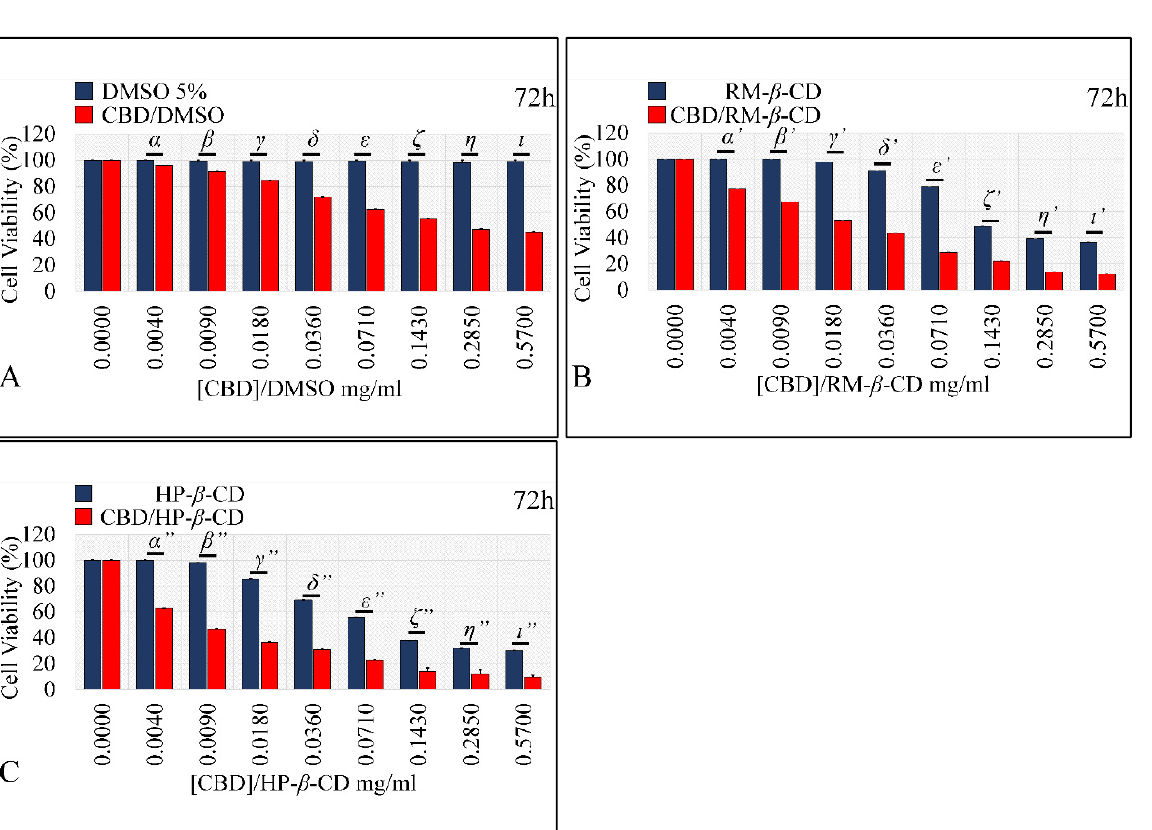
Figure 11. Comparison of vehicle-only and vehicle/CBD complexes on A172 cells at 72 h. ( A ) DMSO did not have any effect on cells, whereas CBD/DMSO manifested significant cytotoxicity as compared to the vehicle at all concentrations, except for the 0.004 mg/mL concentration, and at 72 h. ( B ) RM- β -CD. ( C ) HP- β -CD had a cytotoxic effect, yet the inclusion complexes manifested significantly higher cytotoxicity at all concentrations. The Greek letters above each bars-pair indicate the obtained p-value. In particular, p -values for the DMSO, CBD/DMSO comparison were: α = 0.07, β = 0.02, γ = 0.03, δ = 0.02, ε = 0.009, ζ = 0.018, η = 0.02, ι = 0.013. The p -values for the RM- β -CD, CBD/RM- β -CD comparison were: α ’ = 0.0003, β ’ = 0.005, γ ’ = 0.018, δ ’ = 0.0012, ε ’ = 0.0019, ζ ’ = 0.007, η ’ = 0.0017, ι ’ = 0.007. The p -values for the HP- β -CD, CBD/HP- β -CD comparison were: α ” = 0.002, β ” = 0.002, γ ” = 0.003, δ ” = 0.0009, ε ” = 0.007, ζ ” = 0.01, η ” = 0.017, ι ” =